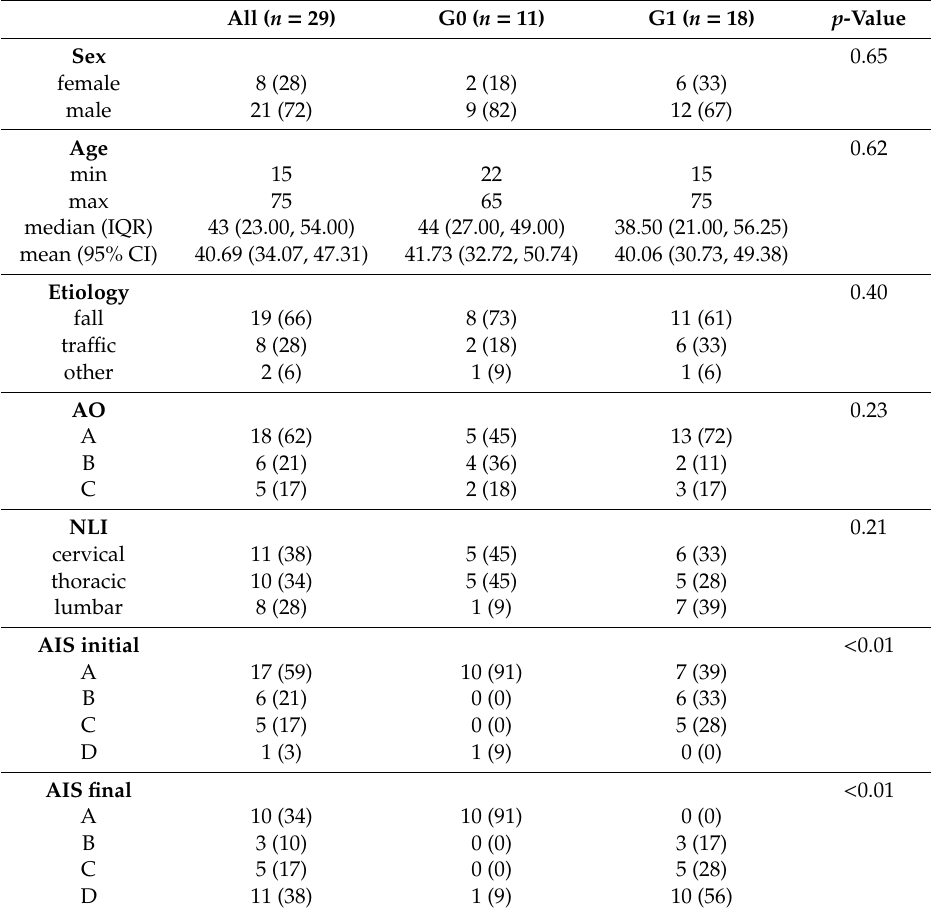
Table 1. Demographic and clinical characteristics of subjects = study group. Abbreviations: NLI = neurological level of injury; AO = AO-classification; AIS = American Spinal Injury Association (ASIA) Impairment Scale. Age is expressed as median / mean years with their corresponding IQR and 95% CI. Neurological remission was defined as improvement in AIS within 3 months after trauma.